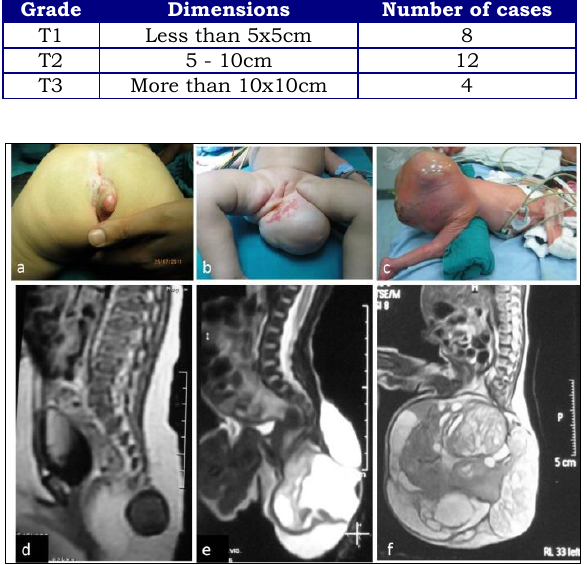
Figure 2: Grading of SCT according to the size of the tumor. (a and d) Grade T1: less than 5 cm. (b and e) Grade T2: between 5 and 10 cm. (c and f) Grade T3: more than 10 cm.